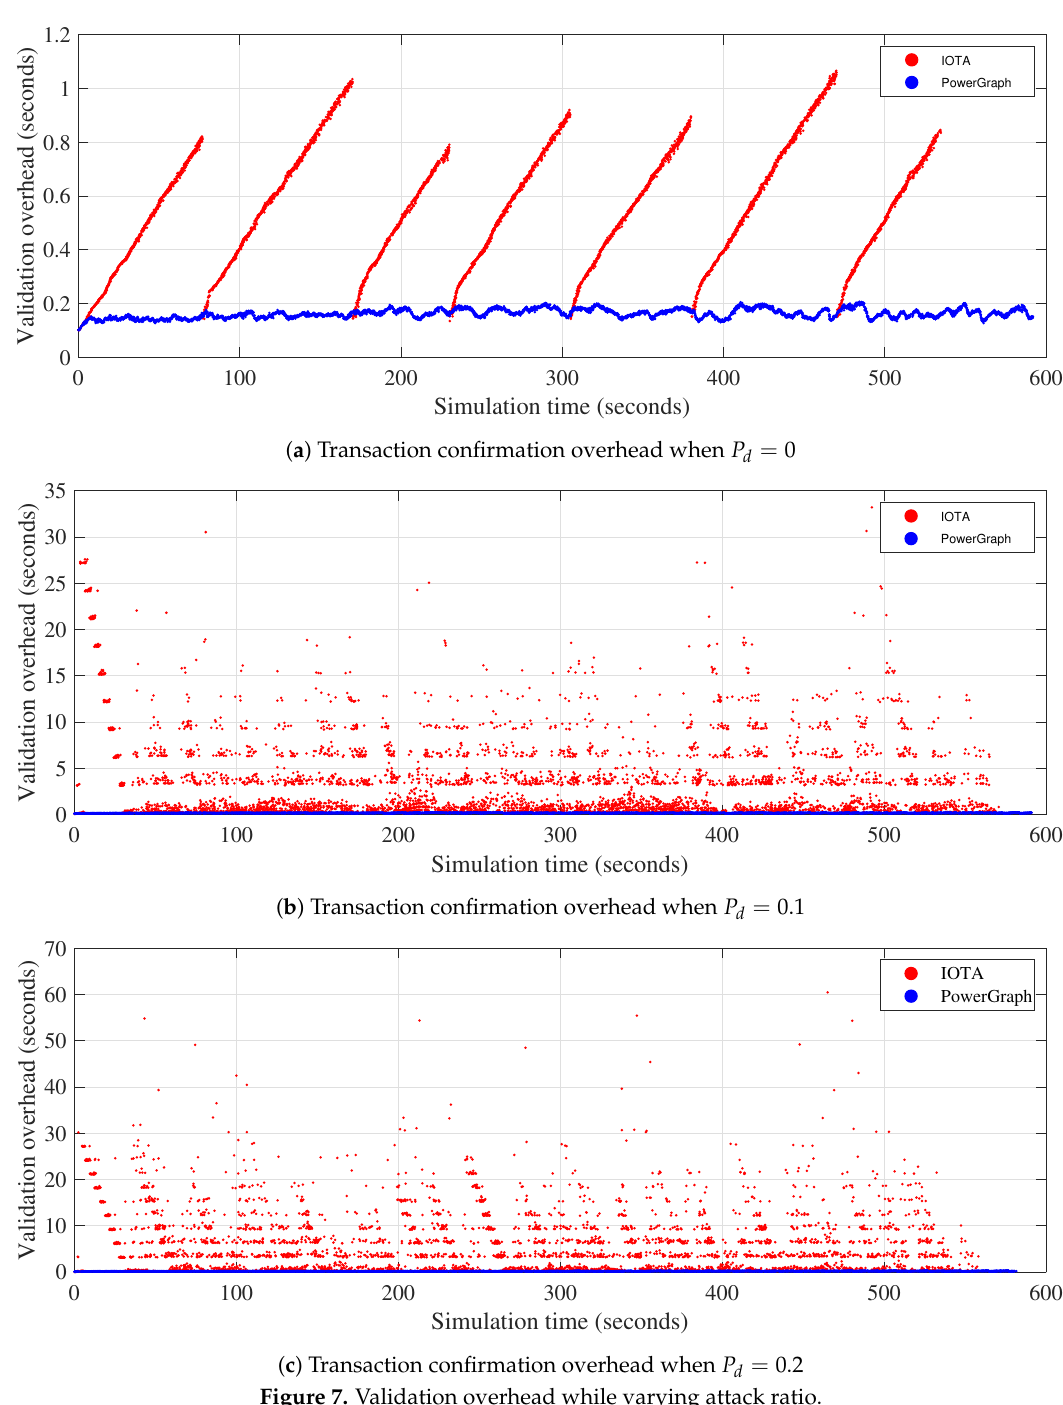
Figure 7. Validation overhead while varying attack